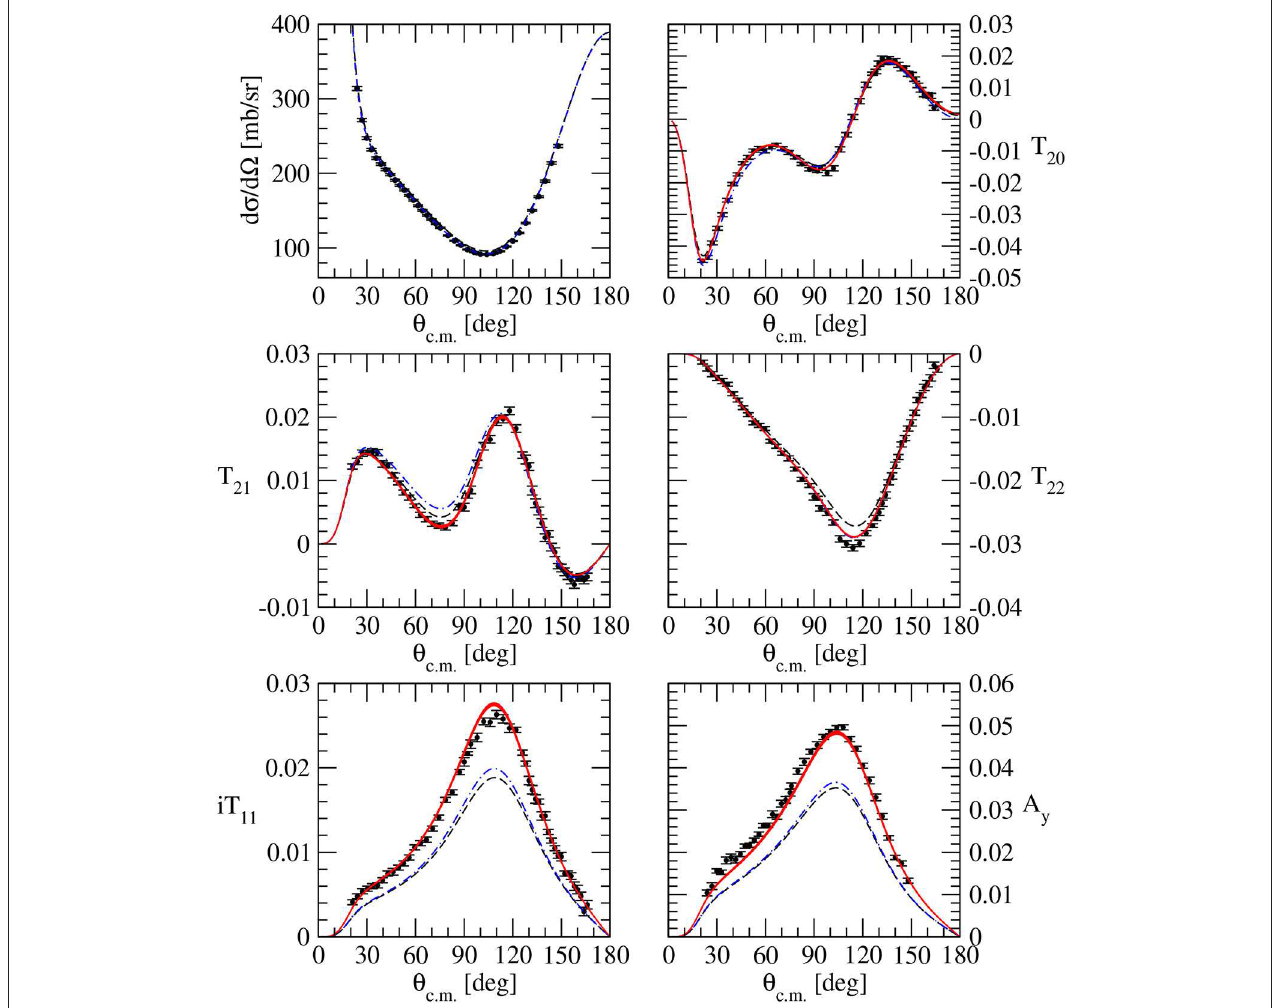
FIGURE 2 | Curves obtained including only the tensor and spin-orbit subleading contact operator on the top of the AV18/UIX interaction, fitted to a set of cross section and polarization observables in p − d elastic scattering at 2 MeV center-of-mass energy [86], for 3 = 200 − 500 MeV (red bands), are compared to the purely two-body AV18 interaction (dashed black lines) and to the AV18/UIX two- and three-nucleon interaction (dashed-dotted blue lines).